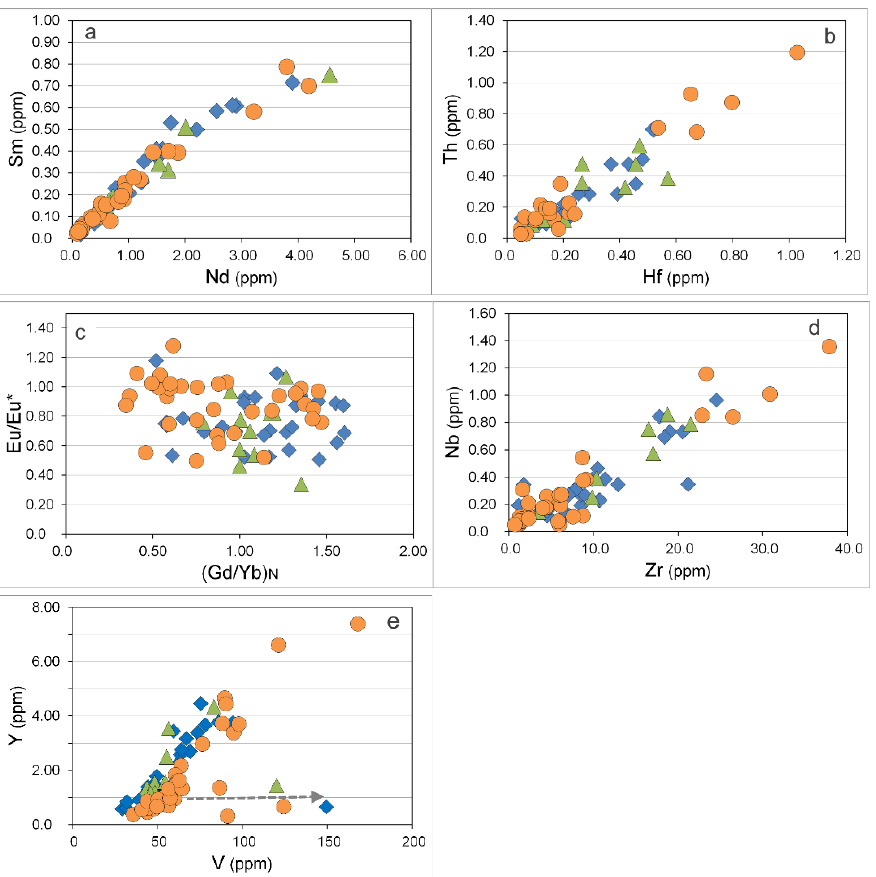
Figure 16. ( a – e ). Plot of values of Nd vs. Sm ( a ), Hf vs. Th ( b ), values of the indexes (Gd/Yb) N vs. Eu/Eu* ( c ), Zr vs. Nb ( d ) and V vs. Y ( e ) expressed in ppm in whole-rock compositions of ultrabasic rocks of the Lyavaraka complex (orange symbol), compared with the related suites of the Chapesvara sill [12] (blue diamonds) and the Khanlauta differentiated flow [13] (green triangles). The dotted arrow in Figure 16e shows the trend of relative V-enrichment caused by the presence of accessory oxide minerals (chromite and